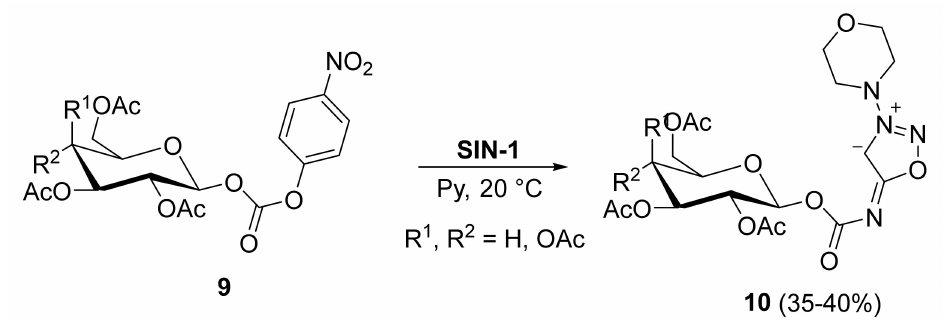
Scheme 5. Synthesis of sydnone imine glycosyl carbamates 10